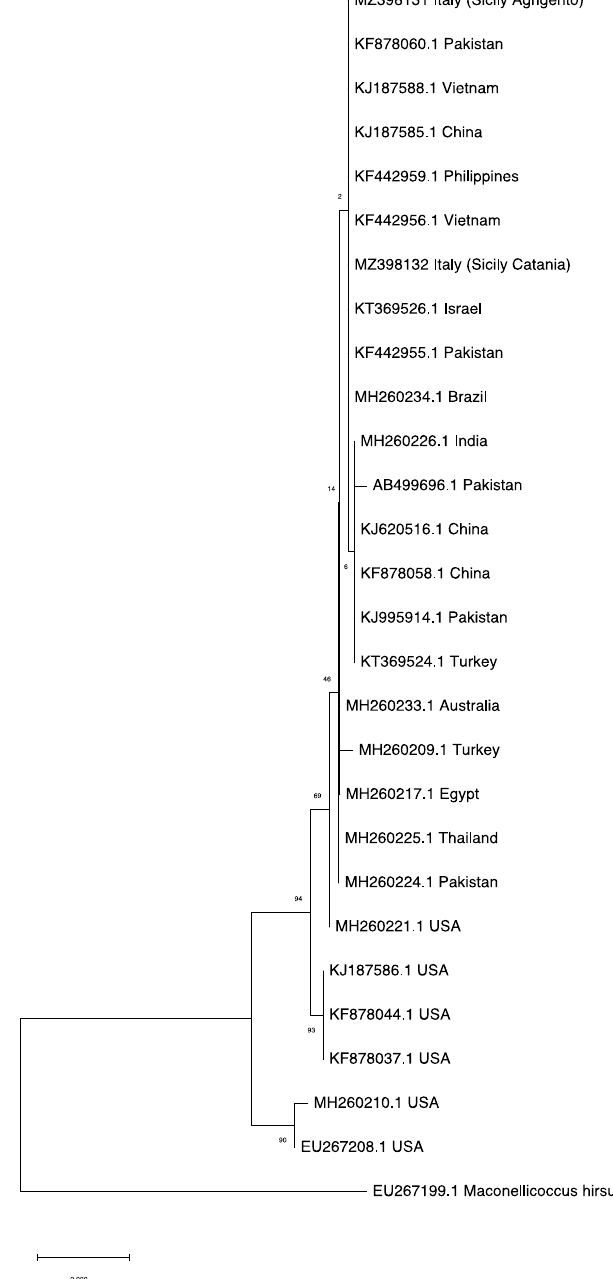
Figure 4. Maximum Likelihood tree, with bootstrap values, based on mtCOI sequences of Phenacoccus solenopsis collected in Sicily clustering with publicly available accessions from invaded (Australia, Brazil, China, Egypt, India, Pakistan, Philippines, Thailand, Turkey, Vietnam) and native (USA) countries retrieved in GenBank (Table S1). Maconellicoccus hirsutus (Accession n. EU267199.1) was used as an outgroup. The tree with the highest log likelihood ( − 1550.08) is shown. The percentage of trees in which the associated taxa clustered together is shown next to the branches. The tree is drawn to scale, with branch lengths measured in the number of substitutions per